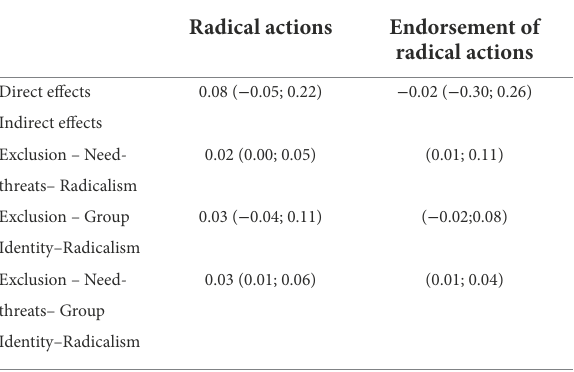
TABLE 2 Direct and indirect effects of exclusion on willingness to participate in radical actions and endorsement of radicalism from bootstrapping with confidence intervals in